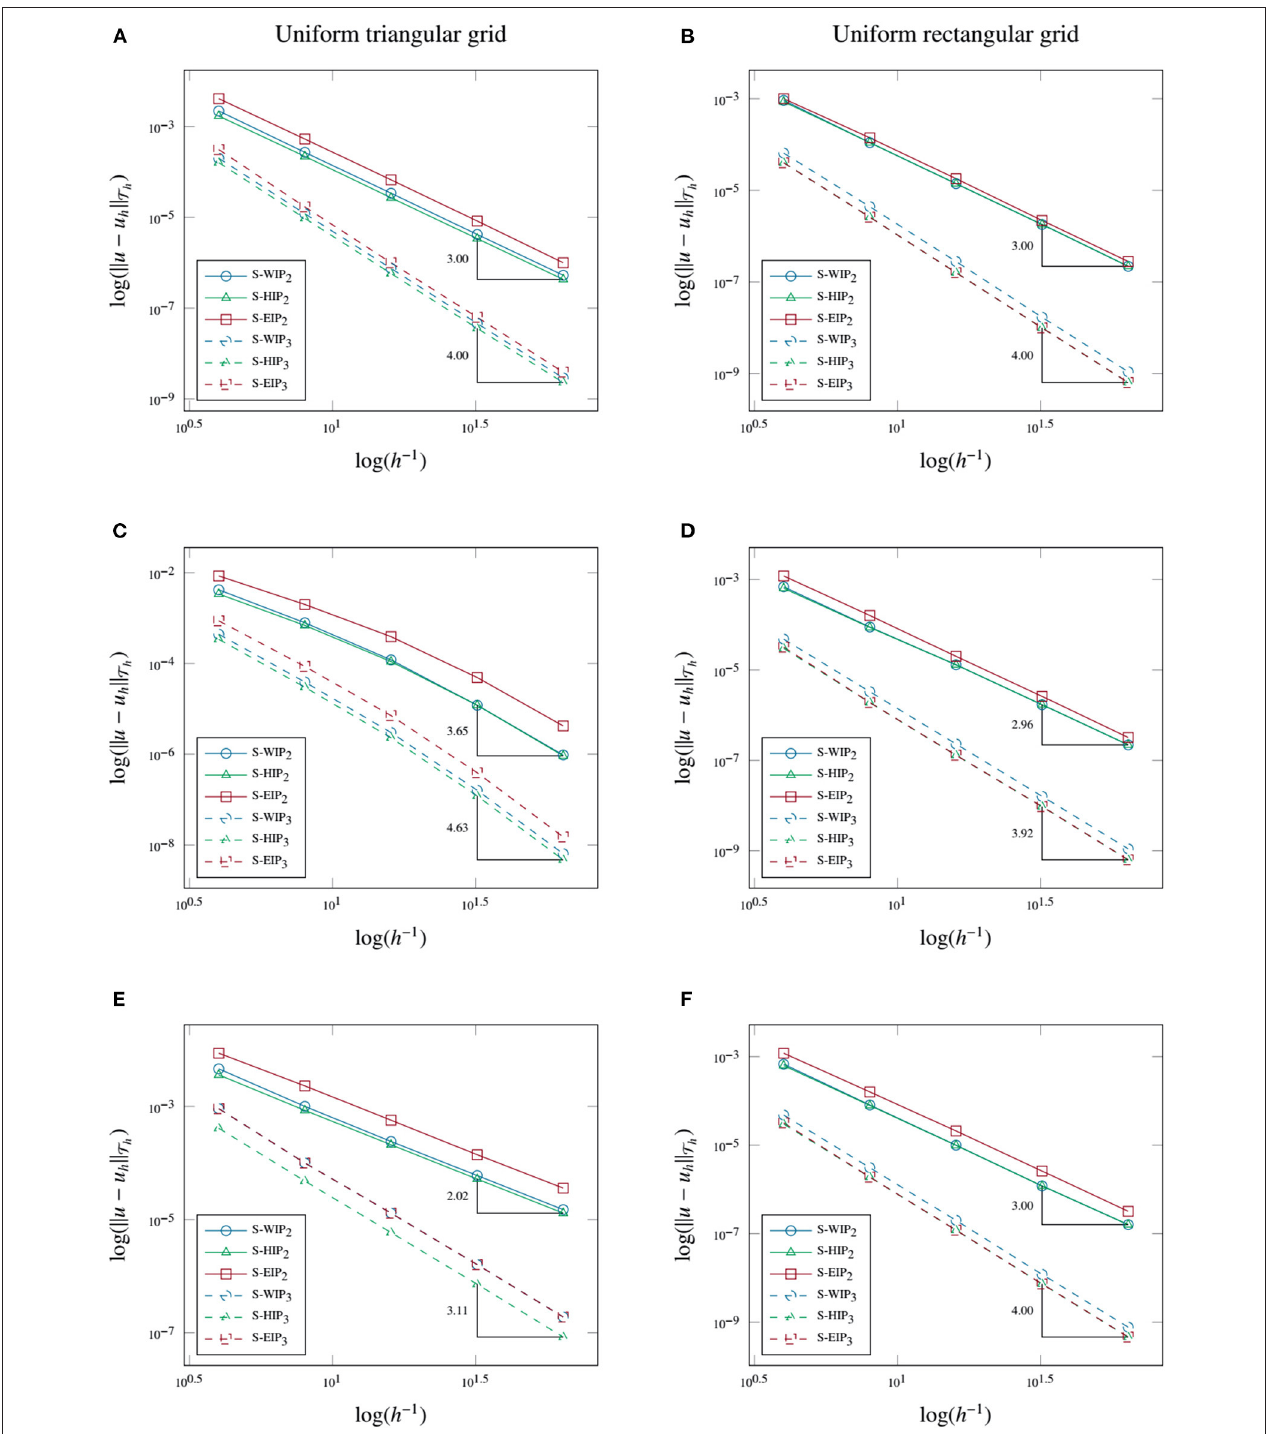
FIGURE 6 | Heterogeneous and anisotropic case - History of convergence in the k · k T λ = 10 3 (C,D) and λ = 10 6 (E,F) , respectively. The grid is triangular in the left (A,C,E) and rectangular in the right (B,D,F) .